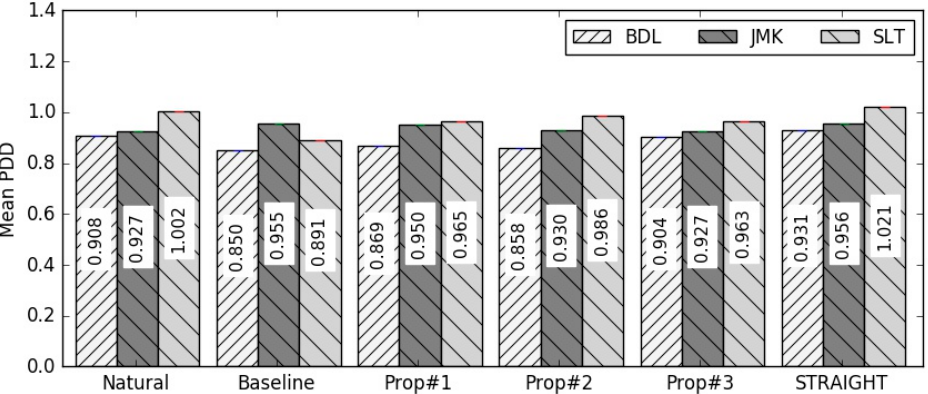
Figure 9. Mean PDD values by sentence type.